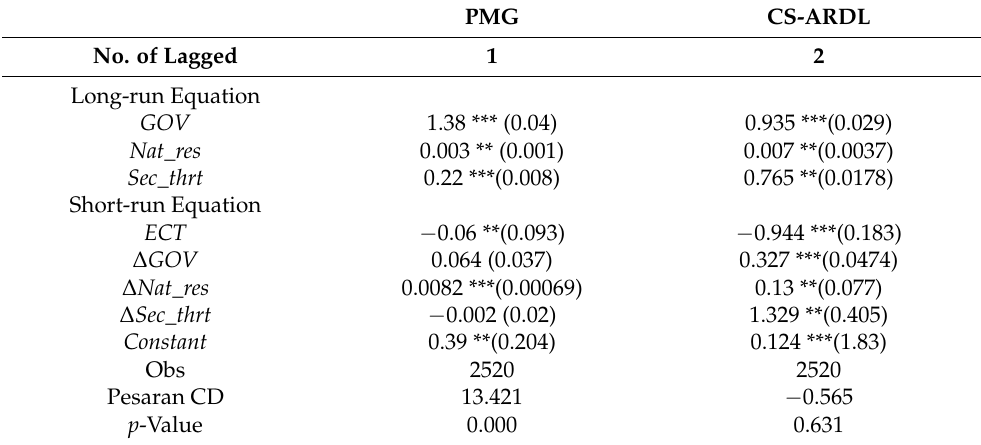
Table 4. Estimated results of long and short-run